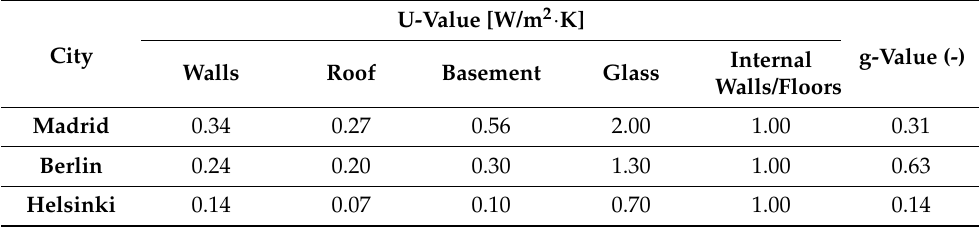
Table 3. Average U-values for office buildings in Spain, Germany and Finland [33–35].